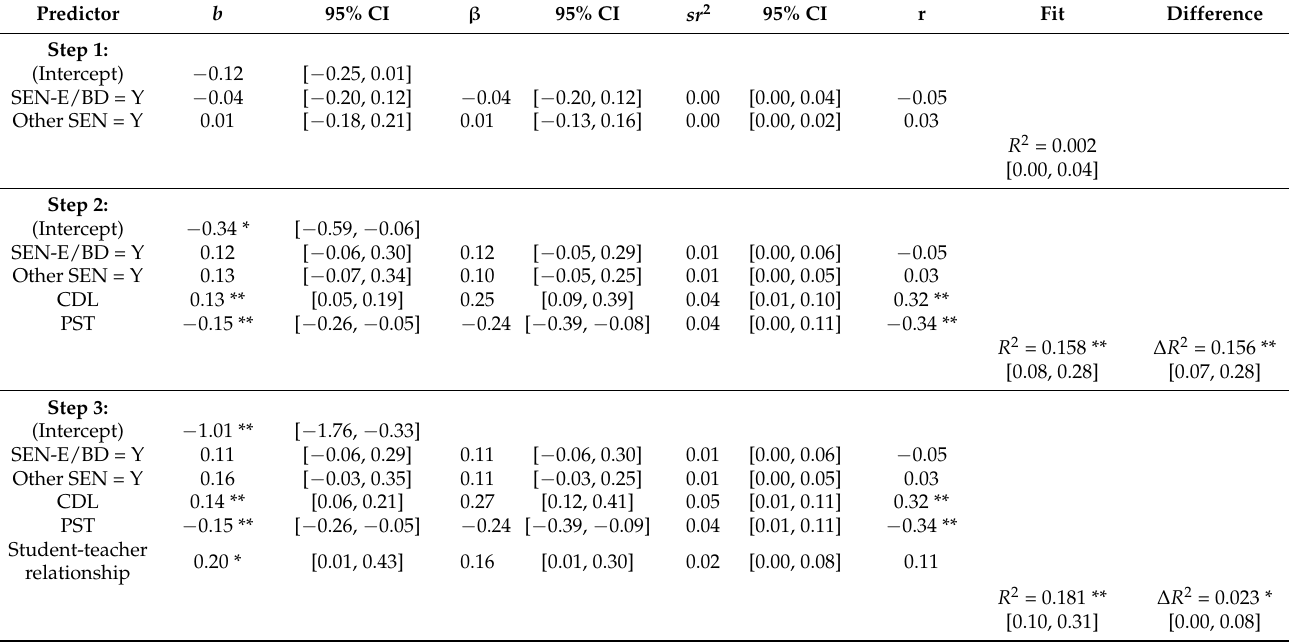
Table 8. Regression results using the lockdown effect on P-SRB as the